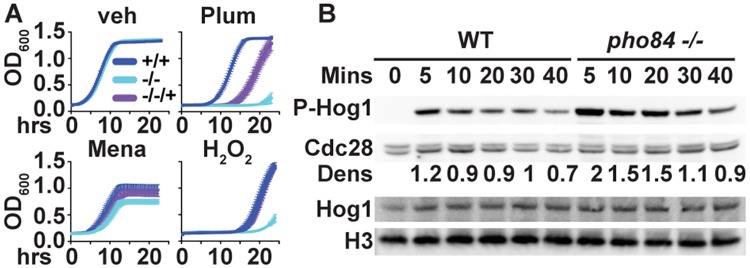
Resistance to oxidative stressors is decreased, and Hog1 phosphorylation is increased in cells lacking PHO84.(A) Cells from overnight liquid cultures were inoculated into YPD with vehicle (veh), 25 μM plumbagin (Plum), 40 μM menadione (Mena), and 40 mM H2O2 to OD600 0.1. OD600 was monitored every 15 minutes for strains +/+, JKC915; -/-, JKC1450 and -/-/+, JKC1588. (B) Western blot of cells incubated in YPD containing 5mM H2O2 for 5 min, 10 min, 20 min, 30 min and 40 min. The membrane was probed for P-Hog1, total Hog1, and loading controls Cdc28 (anti PSTAIRE motif) and Histone H3. Dens: ratio of densitometry of the phosphorylated Hog1 signal to the PSTAIRE signal. Strains, +/+, JKC915; -/-, JKC1450. A and B show representatives of at least 3 biological replicates.